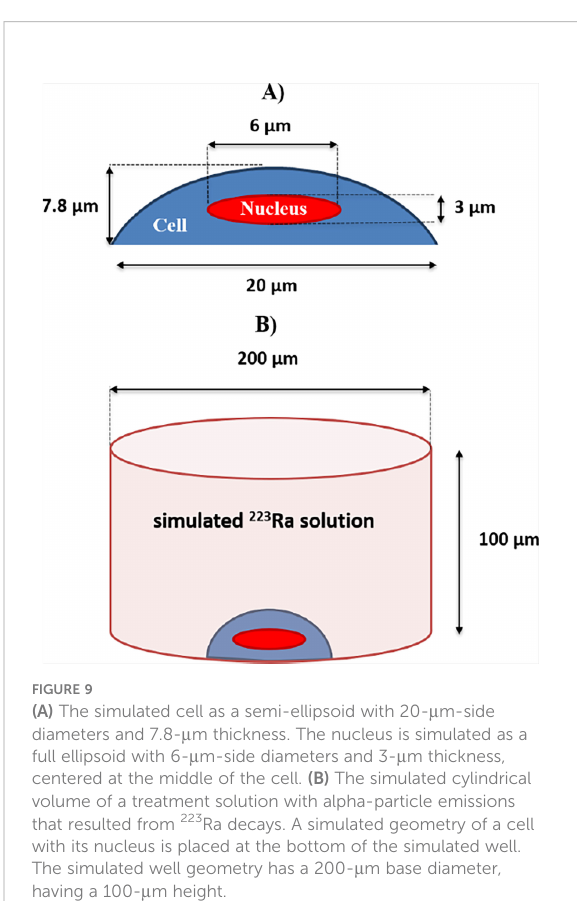
FIGURE 9 (A) The simulated cell as a semi-ellipsoid with 20- m m-side diameters and 7.8- m m thickness. The nucleus is simulated as a full ellipsoid with 6- m m-side diameters and 3- m m thickness, centered at the middle of the cell. (B) The simulated cylindrical volume of a treatment solution with alpha-particle emissions that resulted from 223 Ra decays. A simulated geometry of a cell with its nucleus is placed at the bottom of the simulated well. The simulated well geometry has a 200- m m base diameter, having a 100- m m